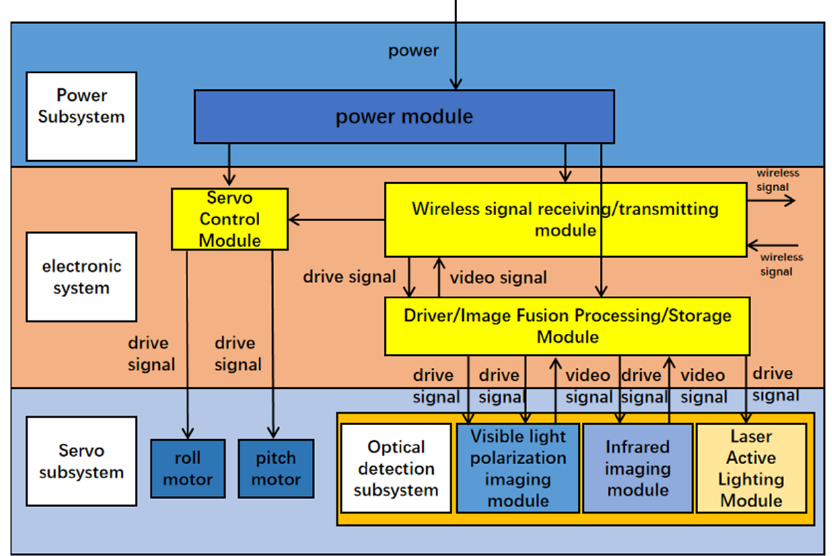
Figure 5. Schematic diagram of system composition.